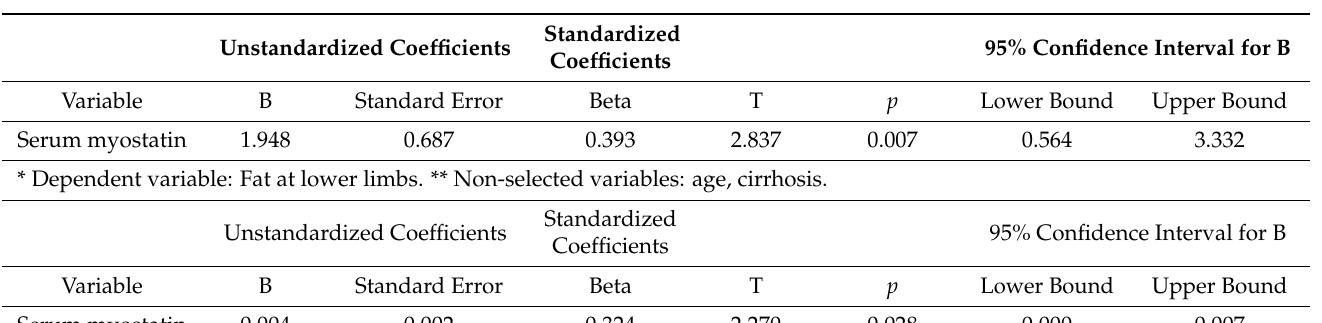
Table 2. Relationships between myostatin and fat variables assessed by stepwise multiple regression